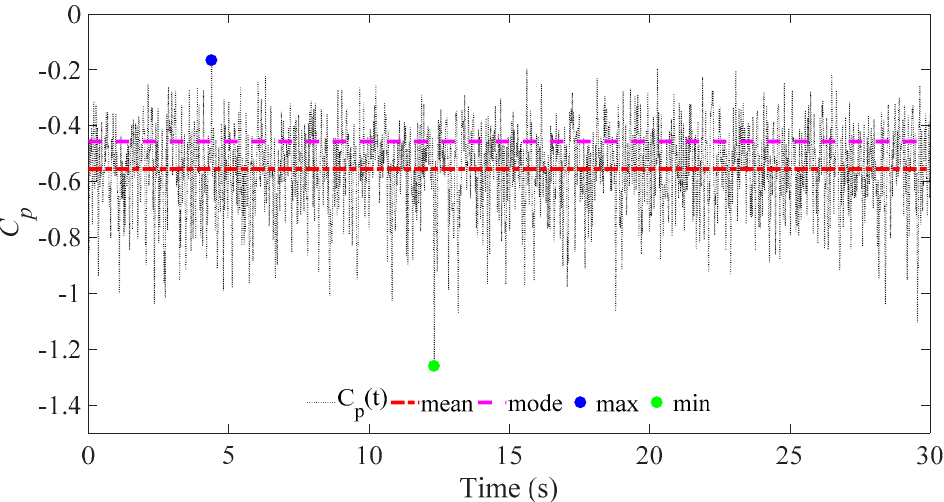
Figure 3. Examples of pressure coefficients time history: model 1, pressure tap #50, wind angle 0°.